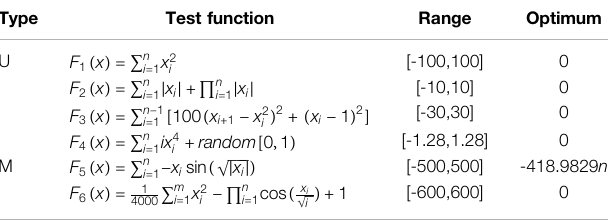
TABLE1| Benchmarkfunctions(U,unimodalfunctions;M,multimodalfunctions). Type Test function Range